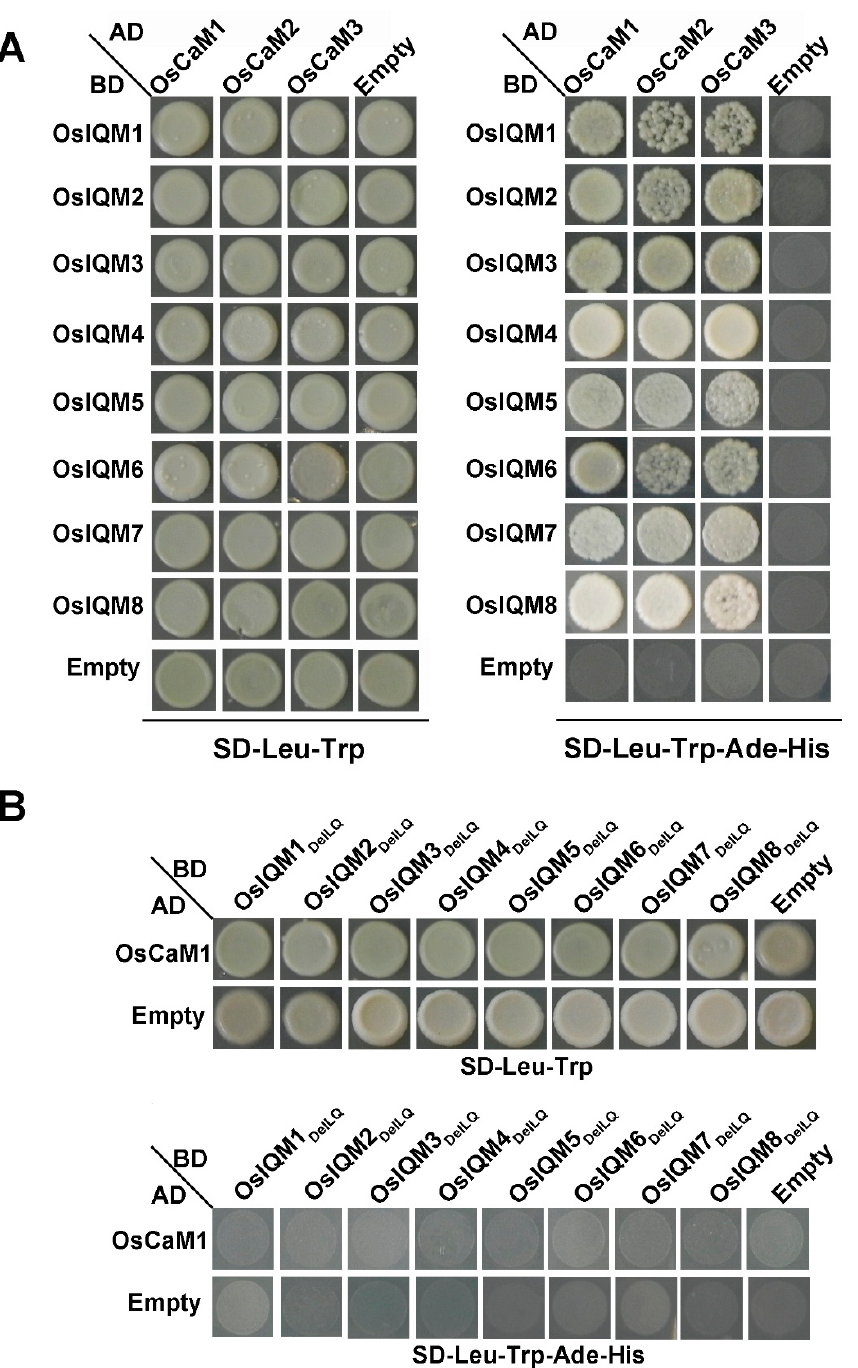
Figure 6. OsIQMs interaction with OsCaMs and exploration of the calmodulin-binding site of OsIQMs. ( A ) The bait con- struct of pGBKT7-OsIQMs and prey construct were co-transformed into the yeast strain AH109 and then were examined on SD/-Trp/-Leu and SD/-Trp/-Leu/-His/-Ade plates. ( B ) The interaction between OsCaM1 and OsIQMs DelLQ . Positive con- trol: pGBKT7-53 and pGADT7-T; Negative control: pGBKT7-Lam and